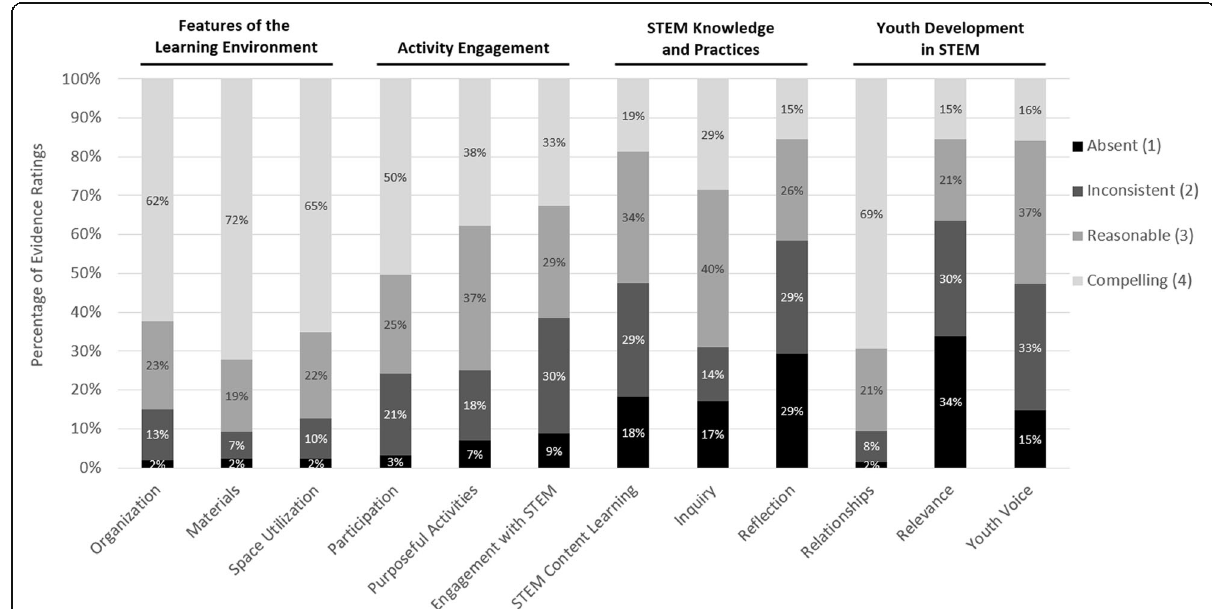
Fig. 2 Stacked bar chart showing proportion of segment-level scores for each dimension of the Dimensions of Success (DoS) observation tool. Darker colors illustrate the pattern of challenges (lower-quality ratings, 1 ’ s and 2 ’ s) and lighter colors illustrate the pattern of strengths (higher- quality ratings, 3 ’ s and 4 ’ s) across all observed programs and states